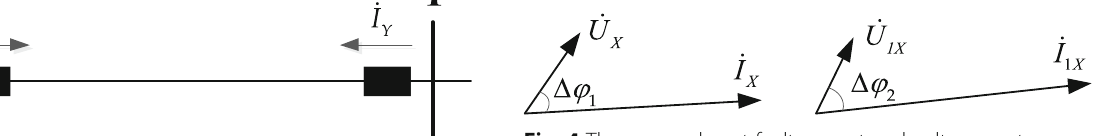
Fig. 4 The pre- and post-fault current and voltage vector graphs of X terminal of situation